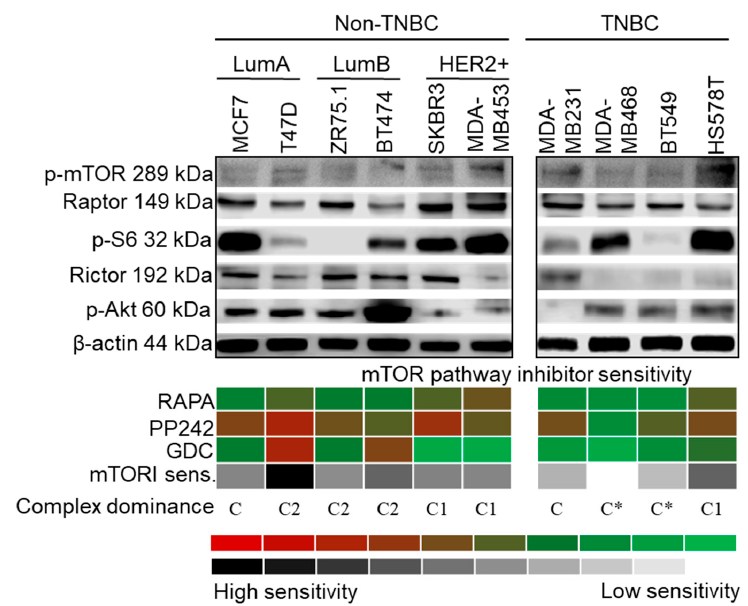
Figure 2. Characteristics of mTOR activity in breast cancer cell lines. Representative Western blots show high mTORC1 and / or C2 activity protein expression patterns (C1—p-mTOR, Raptor and p-S6; C2—p-mTOR,Rictorandp-(Ser473)-Akt(p-Akt)), inacellline-dependent, subtype-independentmanner. In vitro sensitivity to rapamycin (RAPA—50 ng / mL), PP242 (1 µ M) and GDC (1 µ M) (inhibitors of C1, C1 / C2 and Akt, respectively) treatment (72 h) is presented with a colour scheme showing the